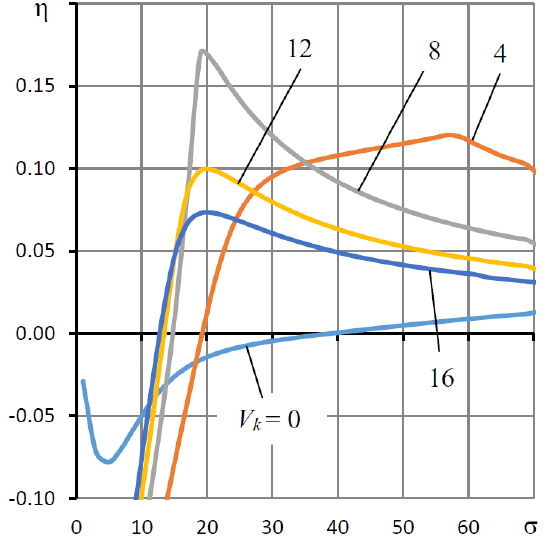
Figure 7. Graph of the dependence of the stability degree η on the “compression number” σ at different values of the volume V k , H d 0 =